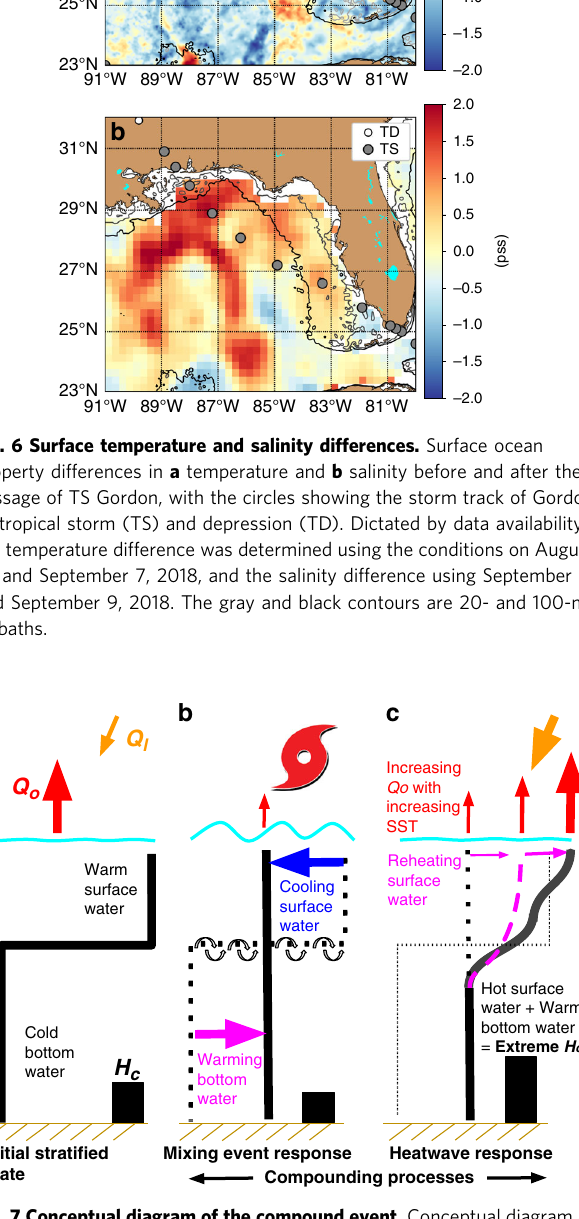
Fig. 7 Conceptual diagram of the compound event. Conceptual diagram of the compound event that resulted in extreme shelf heat content including the a initial strati fi ed shelf, b mixing event response, and c atmospheric heatwave response, showing the water column temperature pro fi le (black thick line), the water column heat content ( H c : thick black bar on the bottom), the incoming solar radiance ( Q I : yellow arrow), and the net heat loss ( Q o : red arrow). The dashed black line in ( b ) and ( c ) indicates the temperature structure from a previous phase of the sequence of events. The magenta dashed line in ( c ) indicates changing upper-layer strati fi cation during the atmospheric heatwave. The changing arrows for Q o re fl ect the dependence of this term on